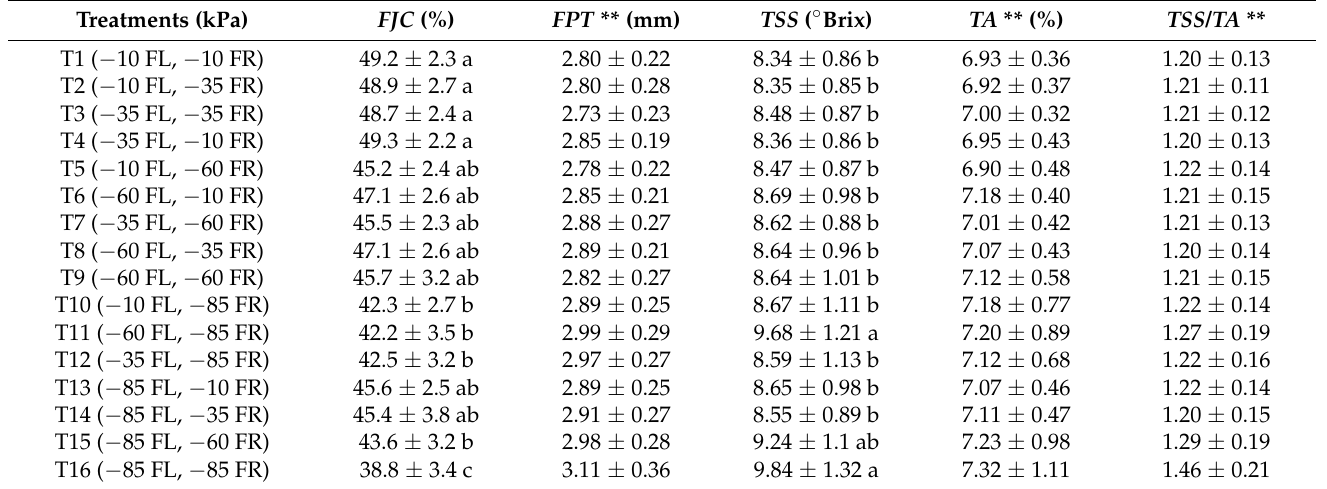
Table 6. Fruit juice content ( FJC ), fruit peel thickness ( FPT ), juice total soluble solids content ( TSS ), juice titratable acidity ( TA ), and TSS / TA